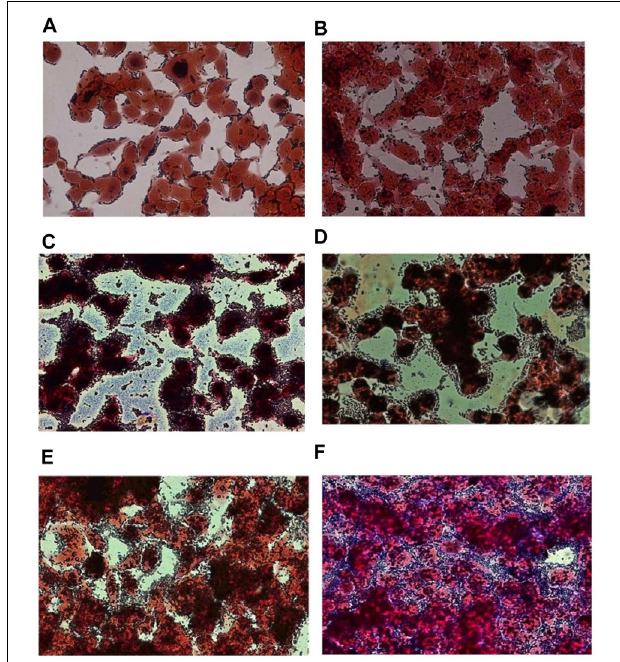
FIGURE 3 | Adhesion of representative Lb. plantarum strains on NCM460 cell cultures observed by microscope (40 × ) after Gram staining, displaying different adhesion attitude: preference in adhering to cell edges or monolayer colonization. (A) Lb. plantarum IMC510 R (cid:13) , probiotic strain; (B) Food-borne Lb. plantarum O5, isolated from table olives; (C) Food-borne Lb. plantarum LAB40, isolated from raw-milk cheeses; (D) Food-borne Lb. plantarum 21B, isolated from sourdough; (E) Food-borne Lb. plantarum LAB62, isolated from raw-milk cheeses; and (F) Food-borne Lb. plantarum C9S2, isolated from